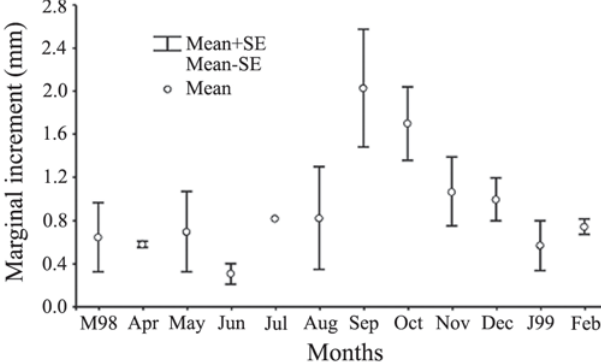
Fig. 2. Monthly average (mean ± standard error; SE) of the marginal increment in scales of the dourado Salminus brasiliensis in the area of influence of Corumbá Reservoir.